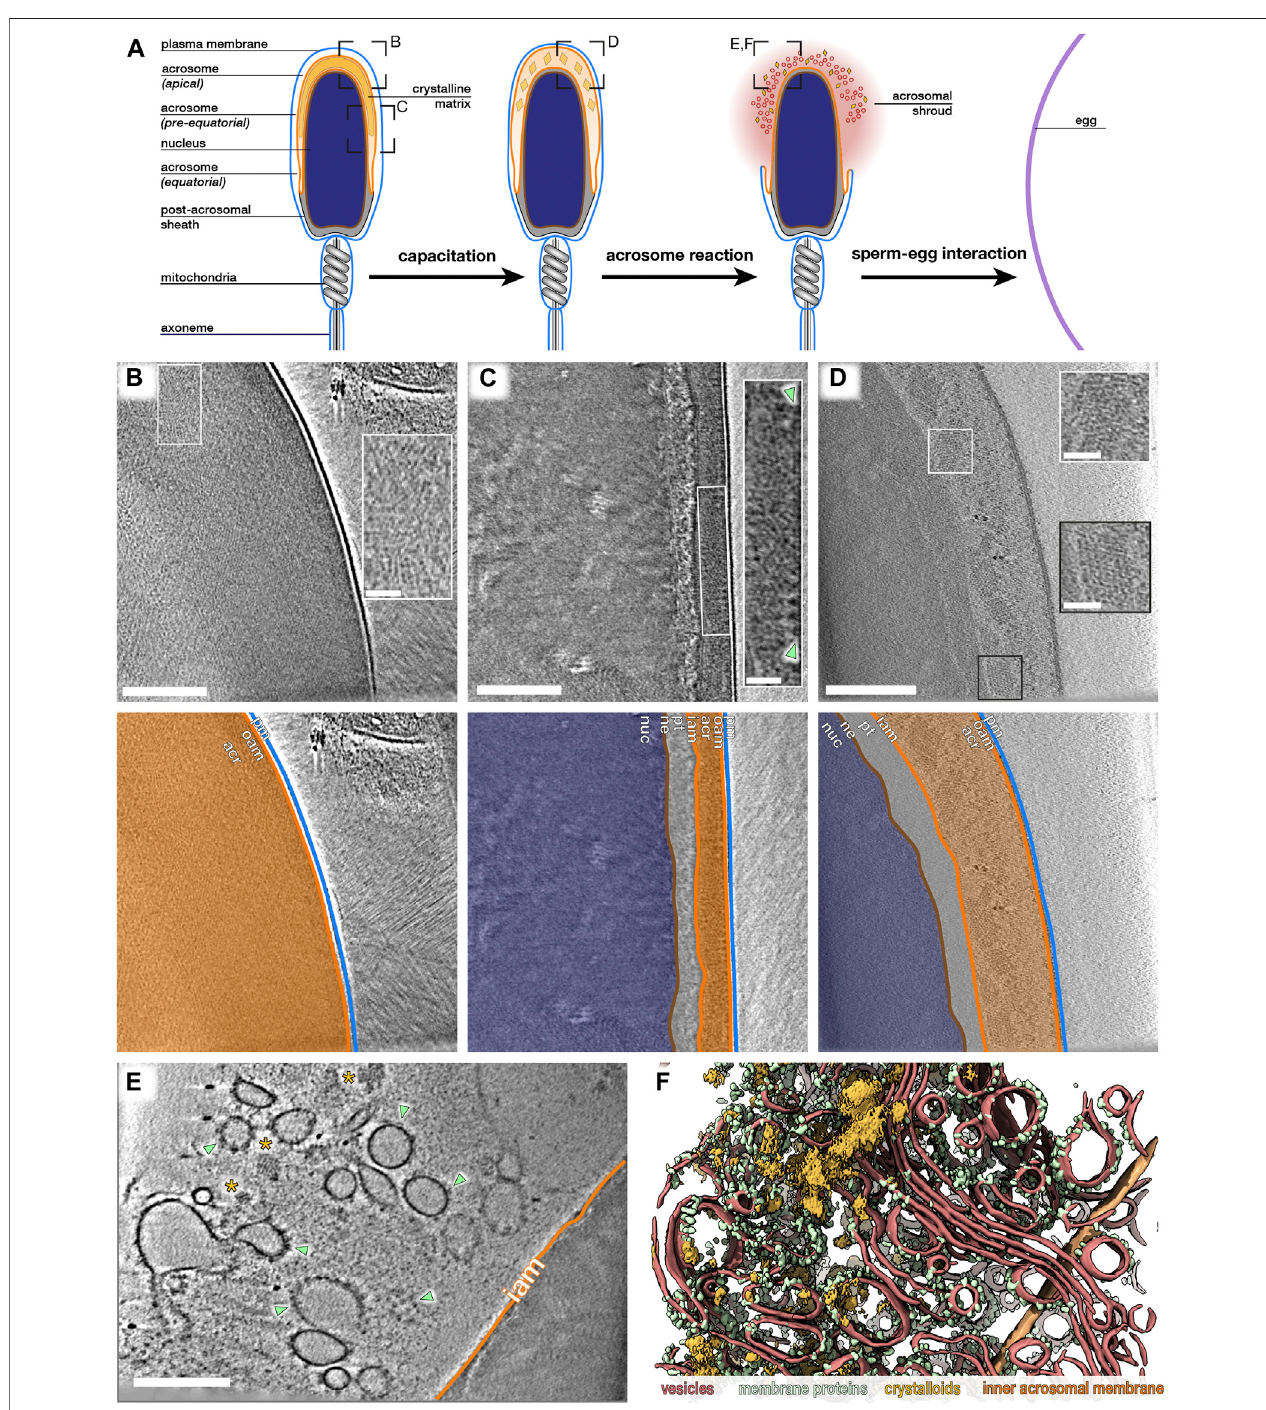
FIGURE 1 | The paracrystalline fraction of the acrosomal matrix progressively disassembles during acrosomal exocytosis. (A) Schematic diagram illustrating the morphologicalchangesthatmammalianspermundergointhefemalereproductivetract,simulatedinthisstudy invitro .Boxedregionsindicateapproximatelocationswheredatain (B – F) were acquired. (B,C) Computational slices through Volta phase plate cryo-tomograms of noncapacitated sperm thinned by cryo-focused ion beam milling. Note how the acrosomeisdenseeveninthinnedsamples.Insetsshowregionswithlargeparacrystallinepatches.Largemembraneproteindensitiesarevisibleontheluminalsurfaceofthe outer acrosomal membrane (green arrowheads in inset). (D) Computational slice through a defocus-contrast cryotomogram of a sperm cell whose acrosome had swollen after incubation in capacitating media for ∼ 2 h. Note the decondensation of the acrosome and the prominent paracrystalline patches (insets). (E,F) Computational slice (E) and corresponding three-dimensional reconstruction (F) of the acrosomal shroud. The cell was incubated in capacitating media for ∼ 2 h and treated with calcium ionophore for ∼ 30 min.Notetheparacrystallinepatches(asterisksin E ,goldenrod in F )and membraneprotein-decorated vesicles(greenarrowheadsin E ,greenin F ).Vesiclemembranesare shown in red, and the inner acrosomal membrane is shown in orange. Scale bars: 250 nm; insets: 50 nm Color scheme: orange — outer and inner acrosomal membrane, red — vesiculated plasma and outer acrosomal membranes, green — membrane protein densities, goldenrod — paracrystalline patches.